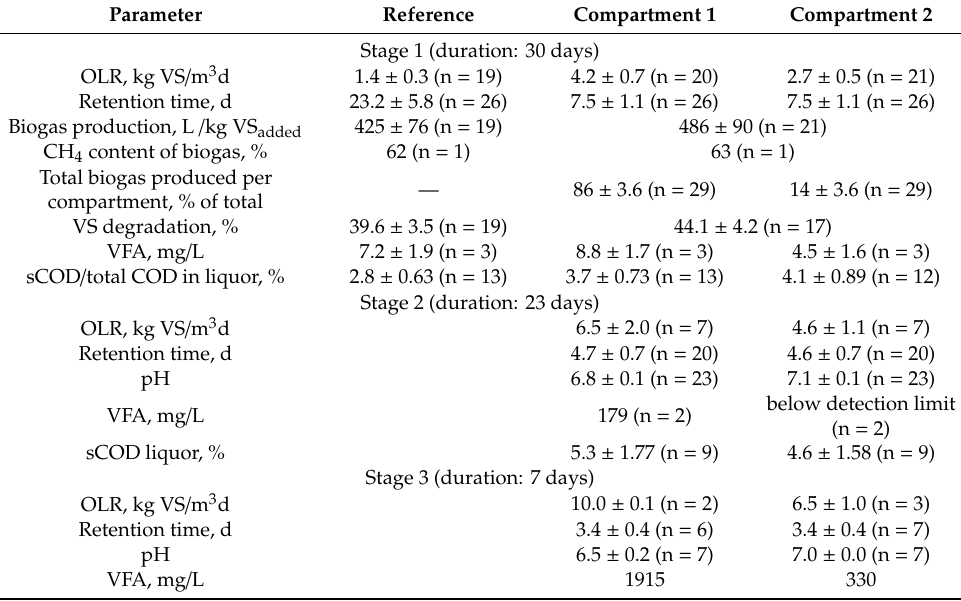
Figure 4. ( a ) Specific biogas production; ( b ) VS degradation and pH of both reactors. Table 2. Reactor performance. OLR, organic loading rate; VFA, volatile fatty acid.